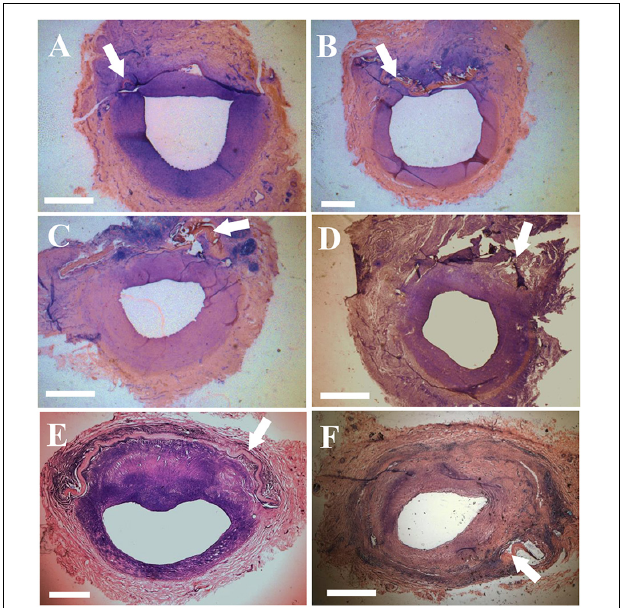
FIGURE 2 | Histological images (H&E stain) of the patch-angioplasties. (A) The sPVP in the carotid artery in 2-M Group. (B) The sPVP in the carotid artery in 4-M Group. (C) The sPVP in the femoral artery in 2-M Group. (D) The sPVP in the femoral artery in 4-M Group. (E) The bPVP in the carotid artery in HF/4-M Group. (F) The bovine pericardium in the carotid artery in HF/4-M Group. White arrows indicate patches. Bar: 1